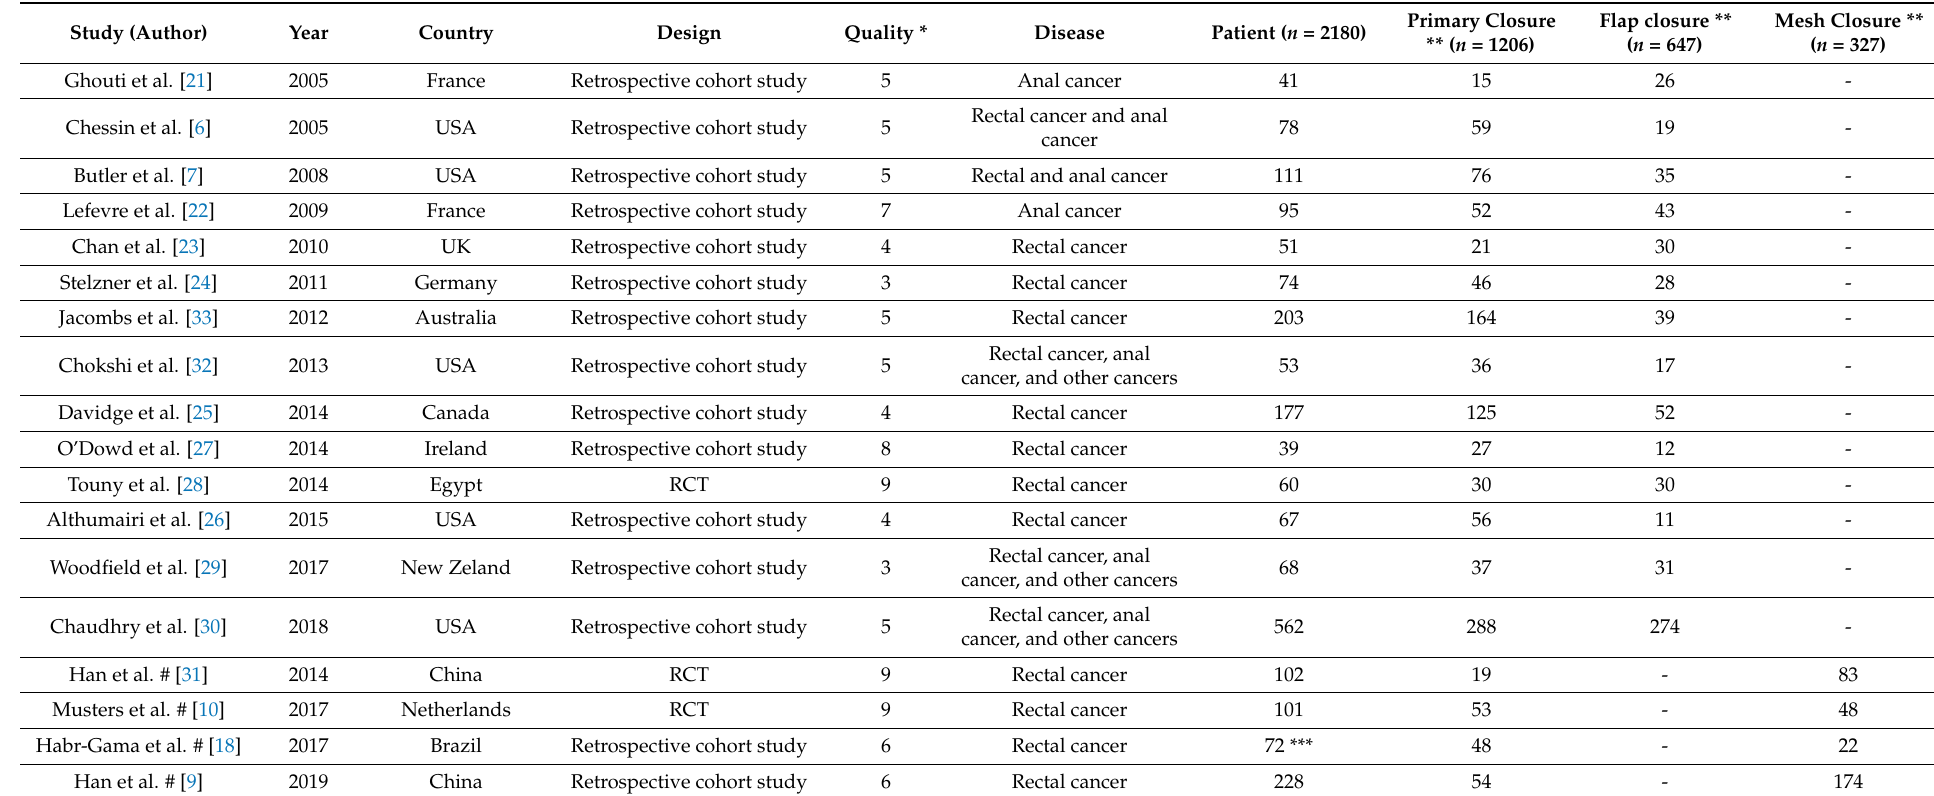
Table 1. Study description of the included